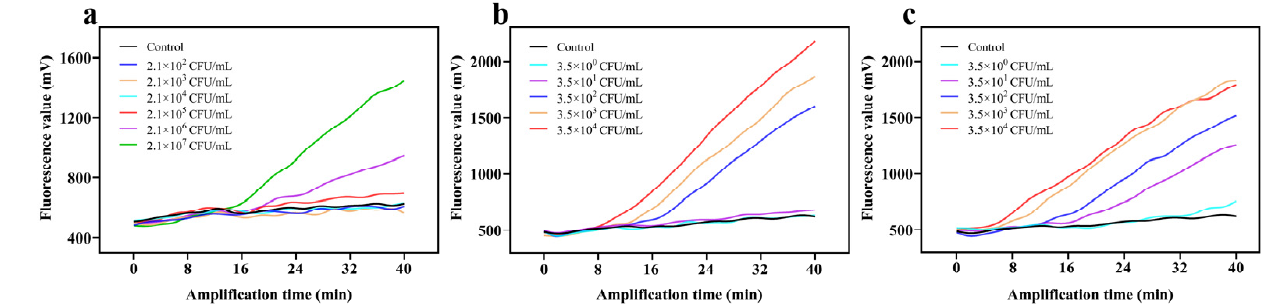
Figure 5. The sensitivity analysis of the TOMA–RAA method for the detection of viable Salmonella in skim milk. ( a ) Fluorescence curve with different concentrations of Salmonella in pure culture; ( b ) Fluorescence curve after 3 h of enrichment; ( c ) the fluorescence curve after 5 h of enrichment.